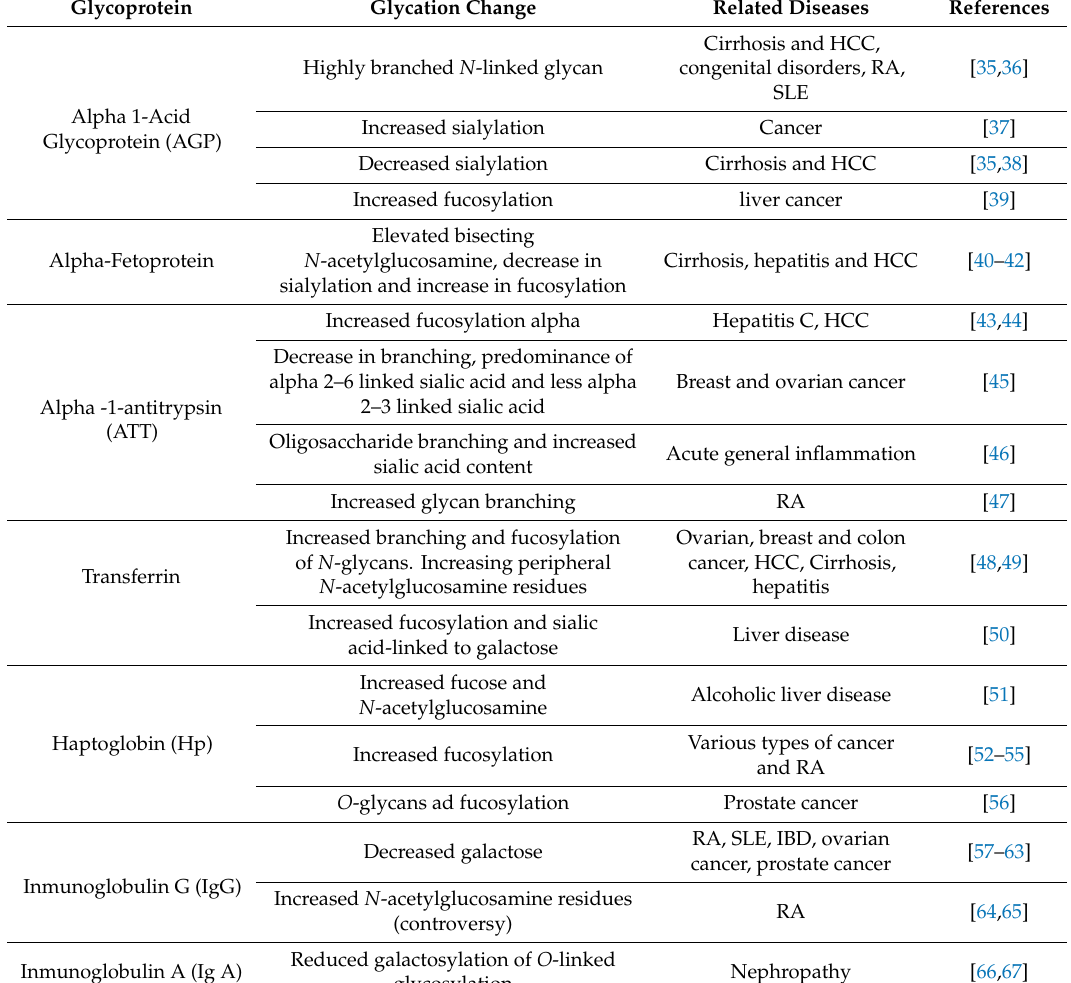
Table 1. Examples of serum protein glycation changes and their association with disease. Glycoprotein Glycation Change Related